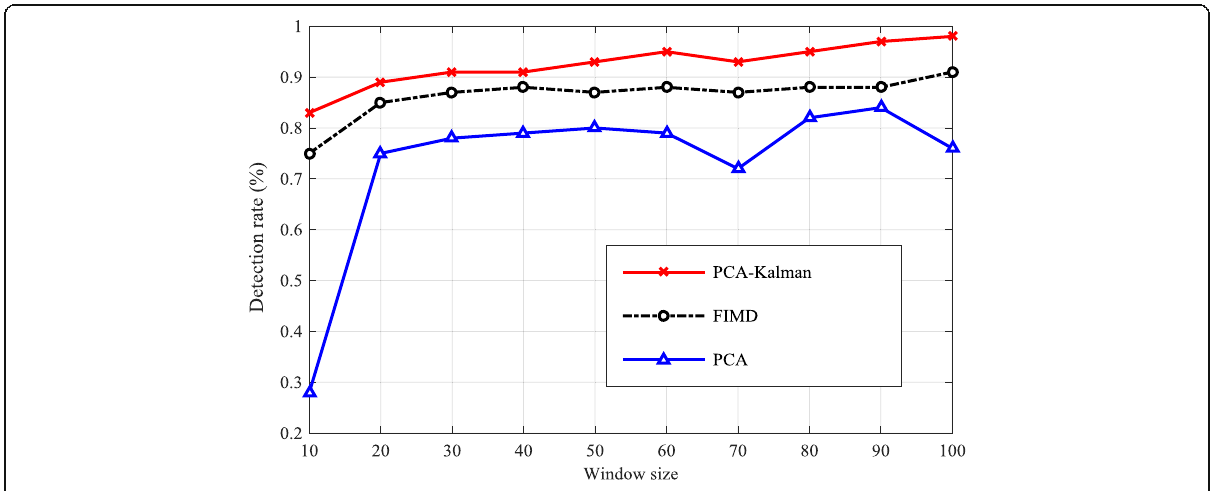
Fig. 13 Impacts of window size on detection